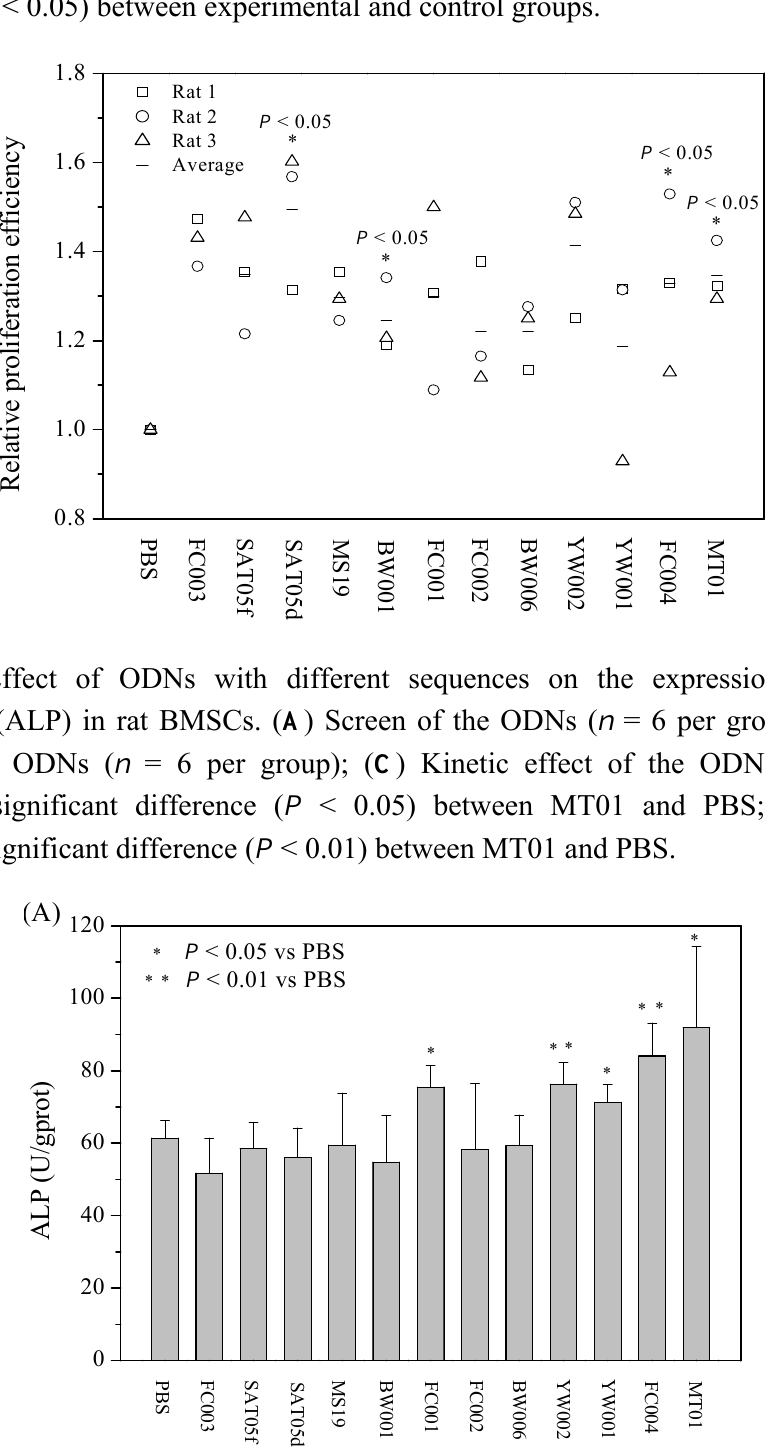
Figure 1. Effect of oligodeoxynucleotides (ODNs) with different sequences on the proliferation of rat bone marrow mesenchymal stem cells (BMSCs). The third passage BMSCs from three different rats were separately seeded in a 96-well-plate at 5 × 10 3 /well and cultured in DMEM for 12 h. After adding ODNs (1 μ g/mL, final concentration), the cells were cultured for 72 h and then subjected to MTT assay. OD570 value was used to express the cell proliferation ( n = 4 per group). * Indicates statistically significant difference ( P < 0.05) between experimental and control groups.